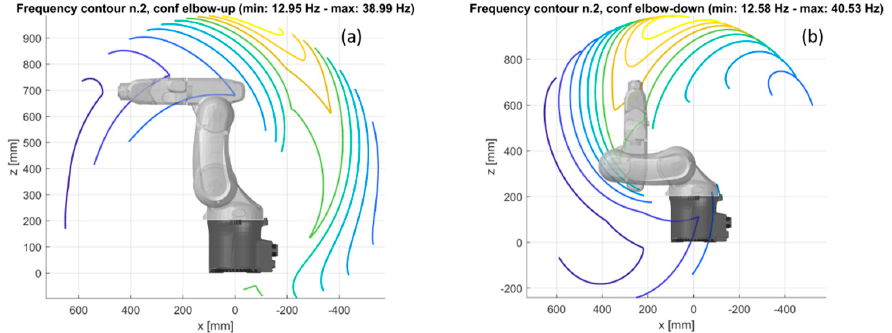
Figure 15. Contour plot of the natural frequency of mode 2 in the meridian plane, ( a ) elbow-up, ( b ) elbow-down.